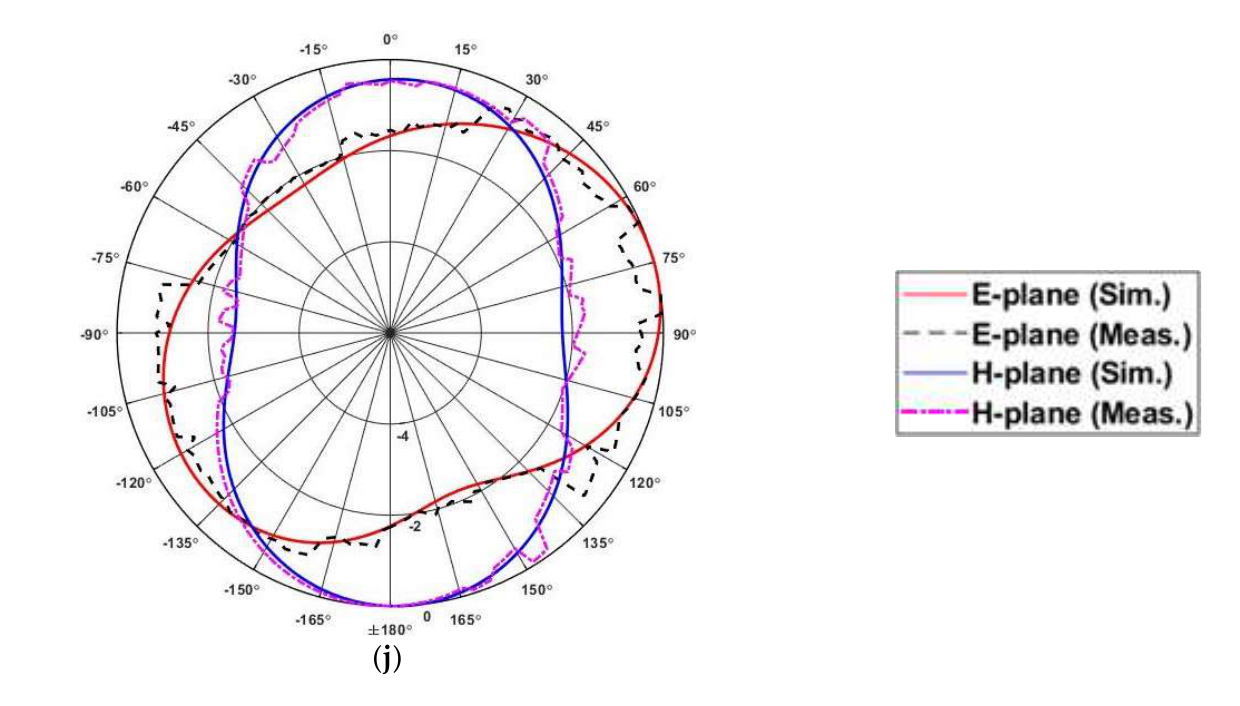
Figure 4. ( a ) Proposed antenna in the anechoic chamber. Simulated and measured antenna co-polarized radiation pattern for E- and H-planes at ( b ) 2.7 GHz, ( c ) 4.05 GHz, ( d ) 5.05 GHz, ( e ) 6.04 GHz, ( f ) 7.15 GHz, ( g ) 7.90 GHz, ( h ) 11.55 GHz, ( i ) 13.11 GHz, and ( j ) 3.1 GHz.